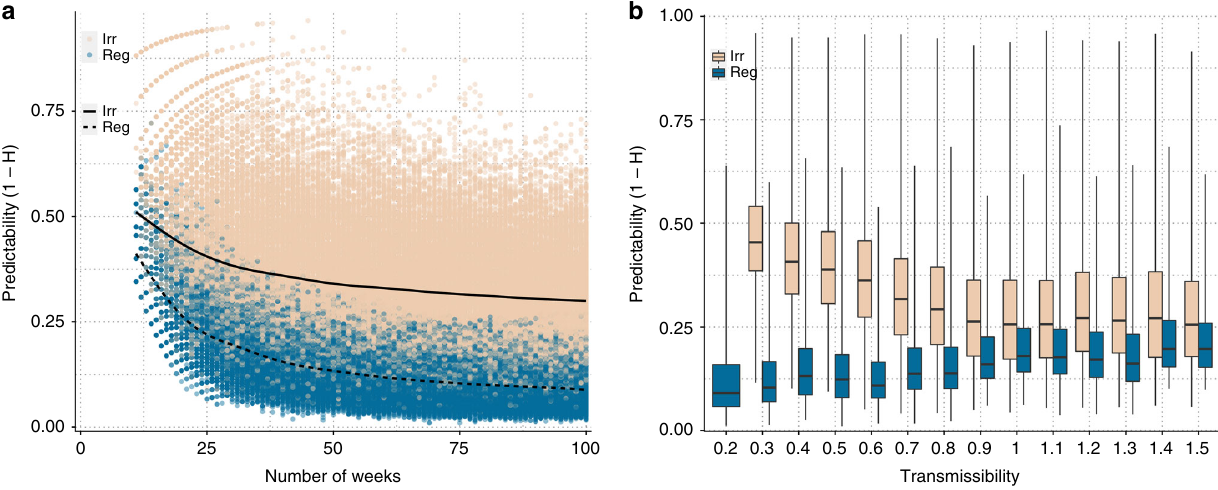
Fig. 5 Predictability decreases with time-series length and contact homogeneity. a For two classes of contact patterns in a synthetic temporal network — regular (reg.), blue and irregular (irr.), brown — we calculate permutation entropy for time series of variable length. For each time-series length we randomly select 1000 starting points and fi nd consistent decreases in the permutation entropy for longer time series. The lines (solid, irr.) and (dashed, reg.) represent the smoothed conditional means, i.e. trend, as determined by fi tting a generalized additive model with a thin-plate spline penalty. b When considering the uniform (reg., blue) and heterogeneous (irr., brown) scenarios separately, we fi nd that the largest difference in predictability is found below the corresponding epidemic transition consistent with the idea that noisy, sputtering infection trees are harder to predict than the epidemic waves above the transition. The solid line represents the median, boxes enclose the 25th to 75th percentiles of the distributions, and whiskers cover the entire distribution. See the “ Epidemic simulations ” section in the Supplementary Materials for details on the simulation